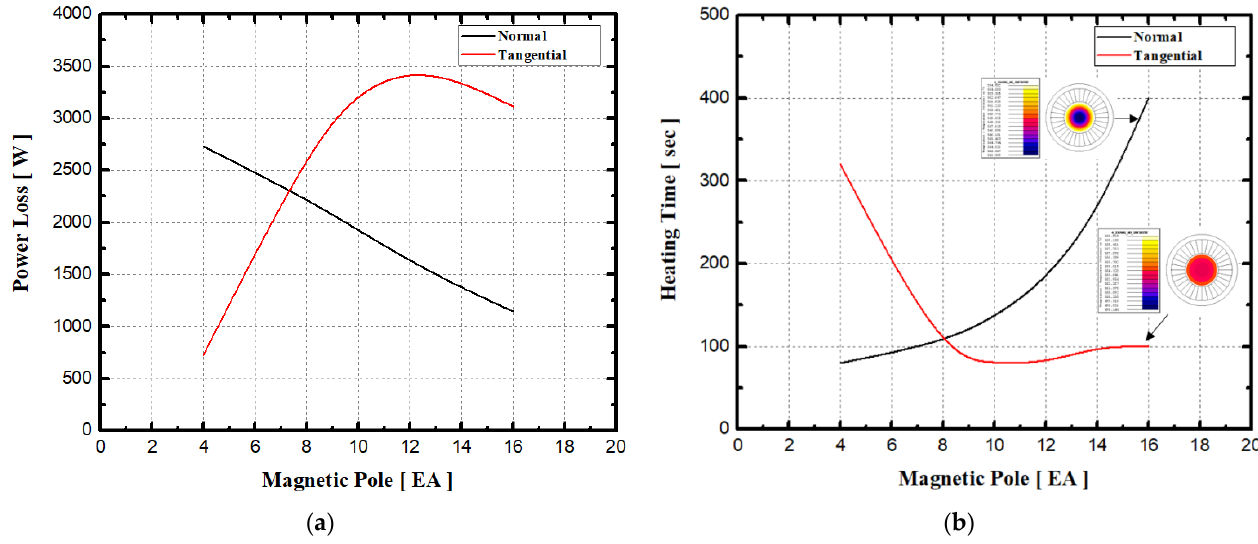
Figure 10. Result graph showing temperature rise to 450 °C according to the change in the number of permanent magnets: ( a ) number of magnets – heating value graph; and ( b ) number of magnets – heating time graph.